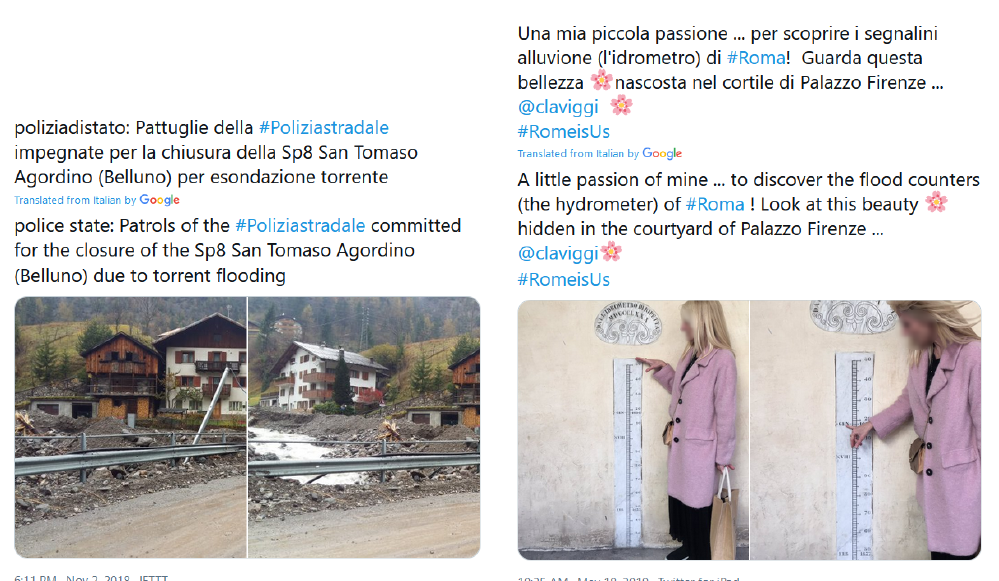
Figure 1. Example of tweets that are relevant ( left ) or not relevant ( right ) to a flood